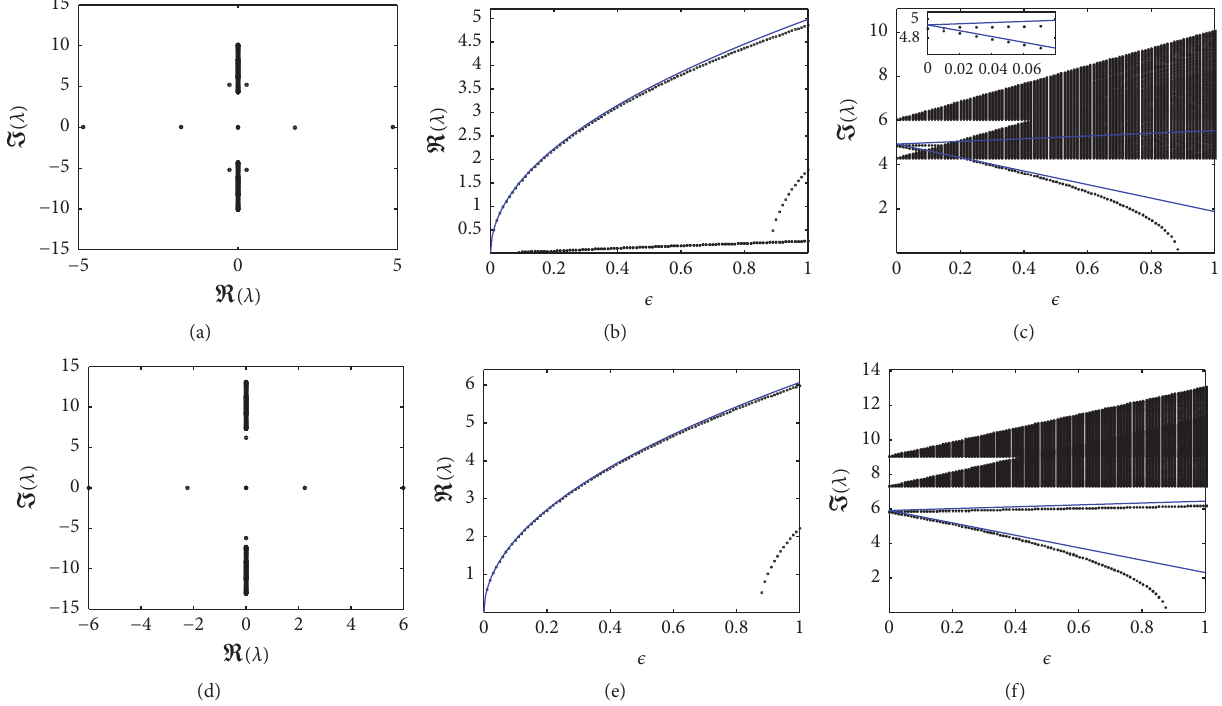
Figure 3: The spectra of intersite soliton II with 𝜔 = 5.2 (a, b, c) and 8.2 (d, e, f) and 𝛾 = 0.5 . The most left panels are the spectra in the complex plane for 𝜖 = 1 . (b, c, e, f) The eigenvalues as a function the coupling constant. Solid blue curves are the asymptotic